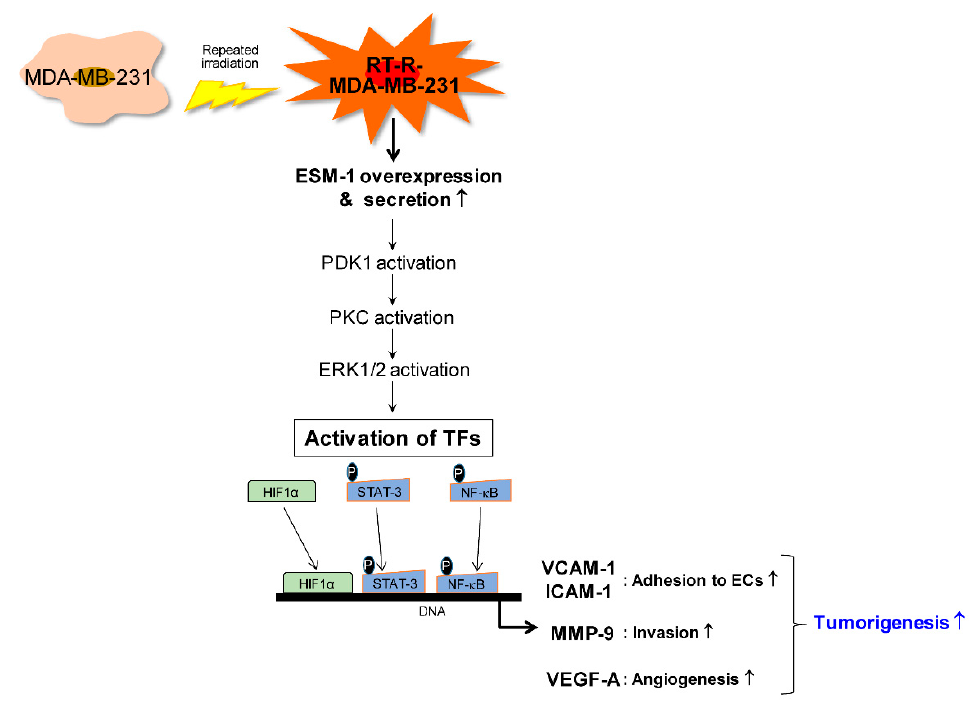
Figure 7. Schematic presentation of the mechanism by which ESM-1 plays an important role in the tumorigenesis of breast cancer cells.